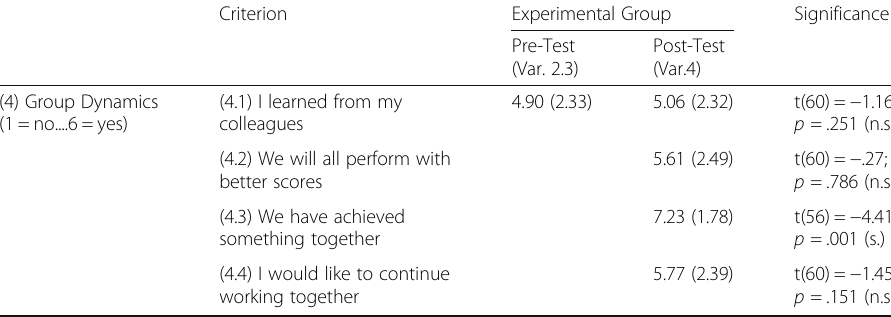
Table 2 Significance between Pre-Test Variable (2.3) and Post-Test Variable (4.1 to